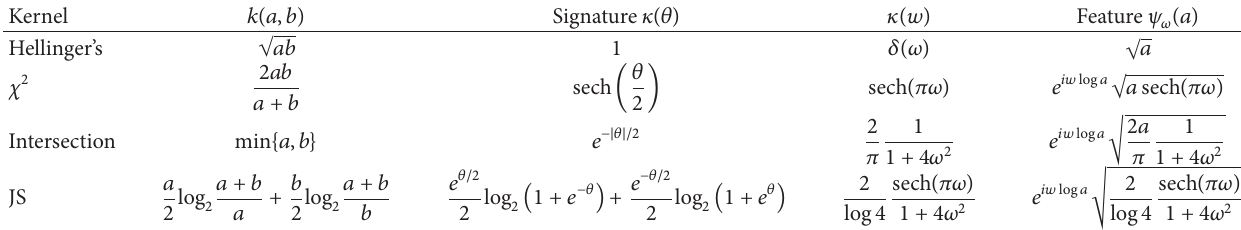
Table 1: Common kernels, signature, and their feature